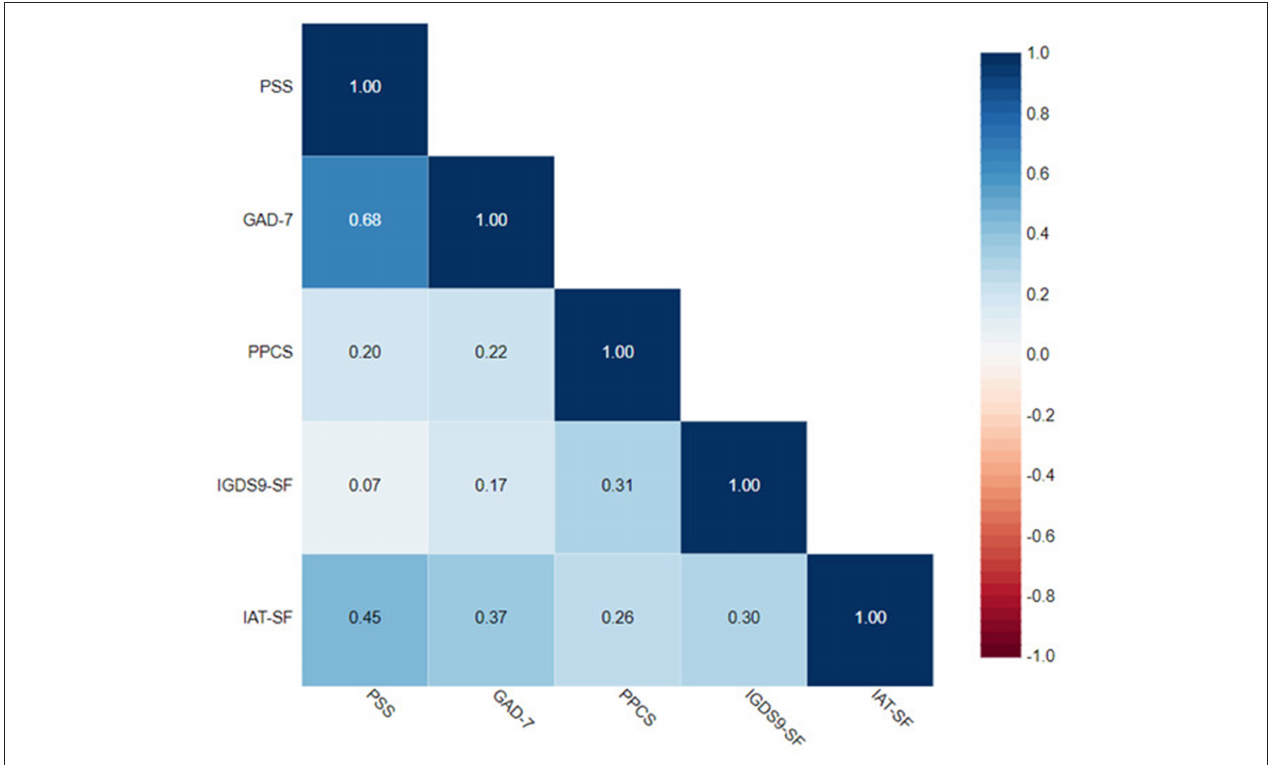
FIGURE 1 | Correlation